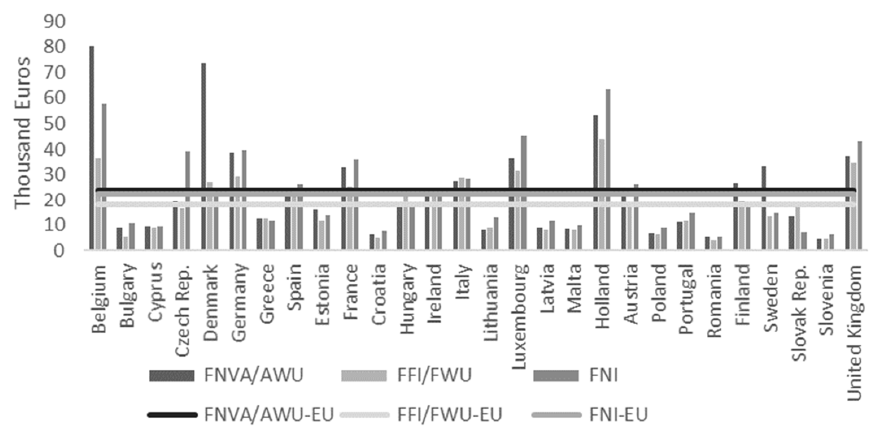
Figure 1. Income indicators of the EU member states (average of 2009–2018). Source: own calculations.